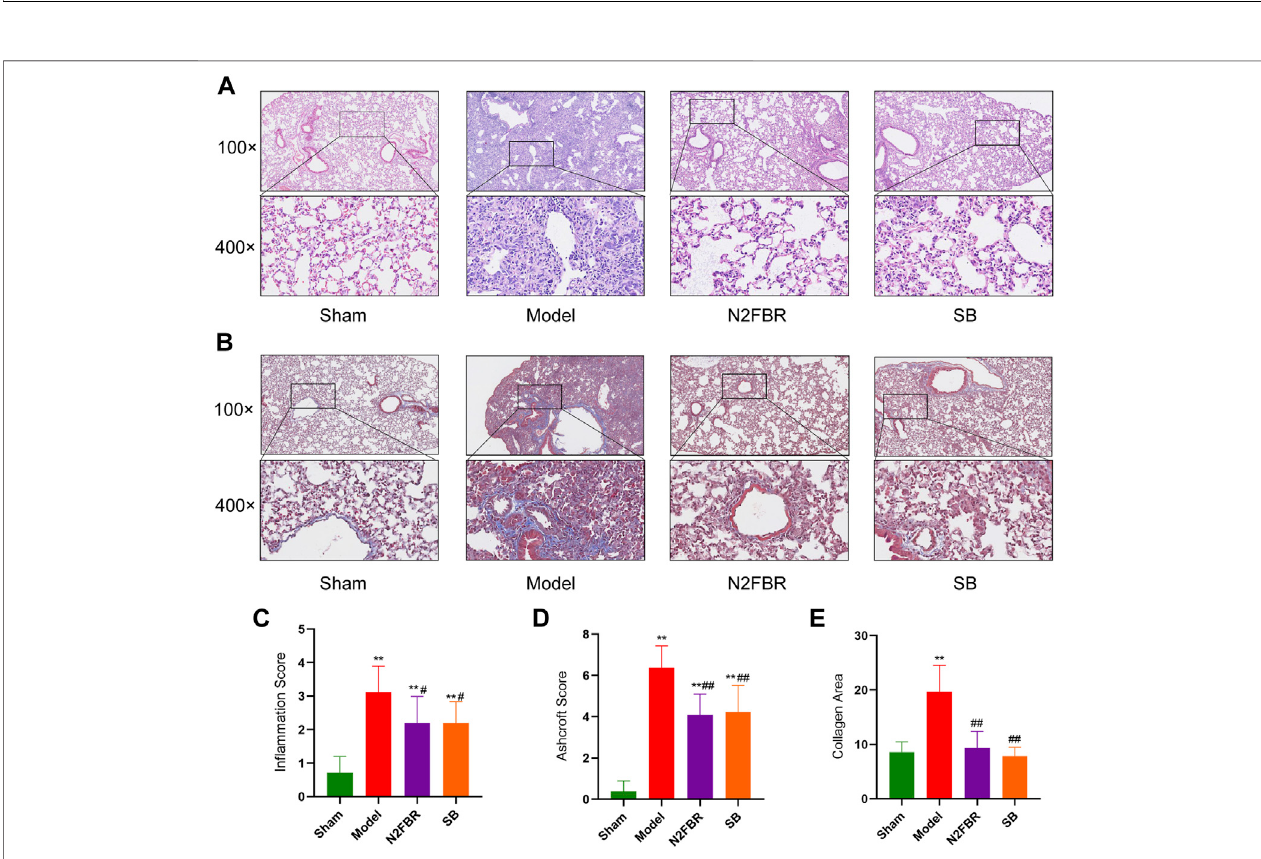
FIGURE 1 | Number of deaths and changes in body weight of mice ( n = 10 mice/group). (A) The survival curve of mice. (B) Changes in body weight of mice.